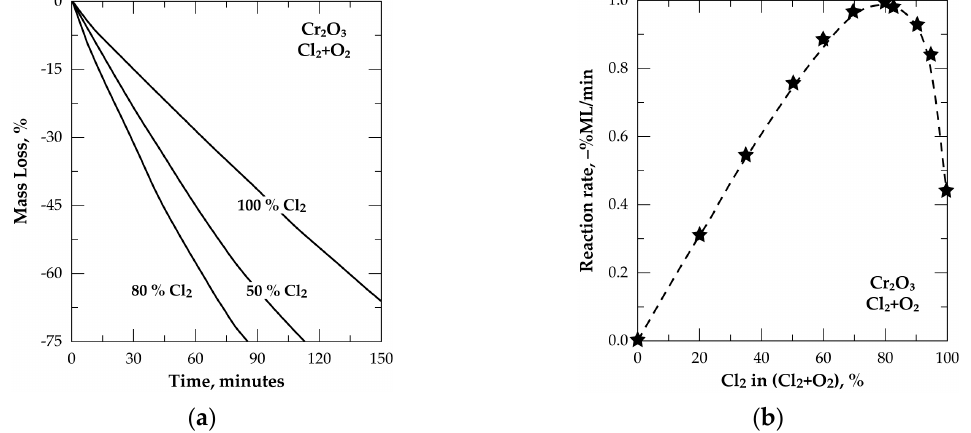
Figure 11. Treatment of Cr 2 O 3 in Cl 2 +O 2 at 800 °C: ( a ) Evolution of the sample mass loss versus time; ( b ) Dependency of the initial reaction rate on the chlorine content in the Cl 2 +O 2 gas mixture.